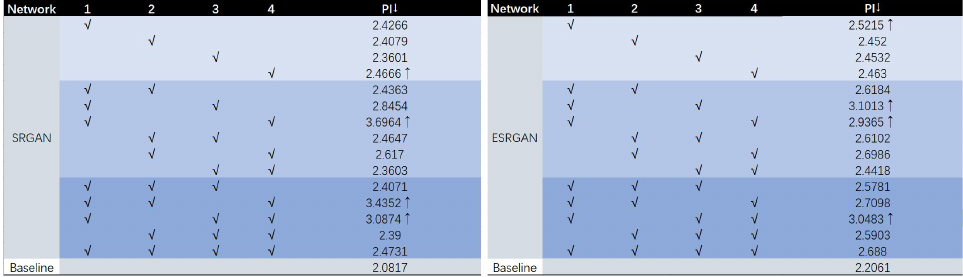
Figure 7. The results of quantization sensitivity test.